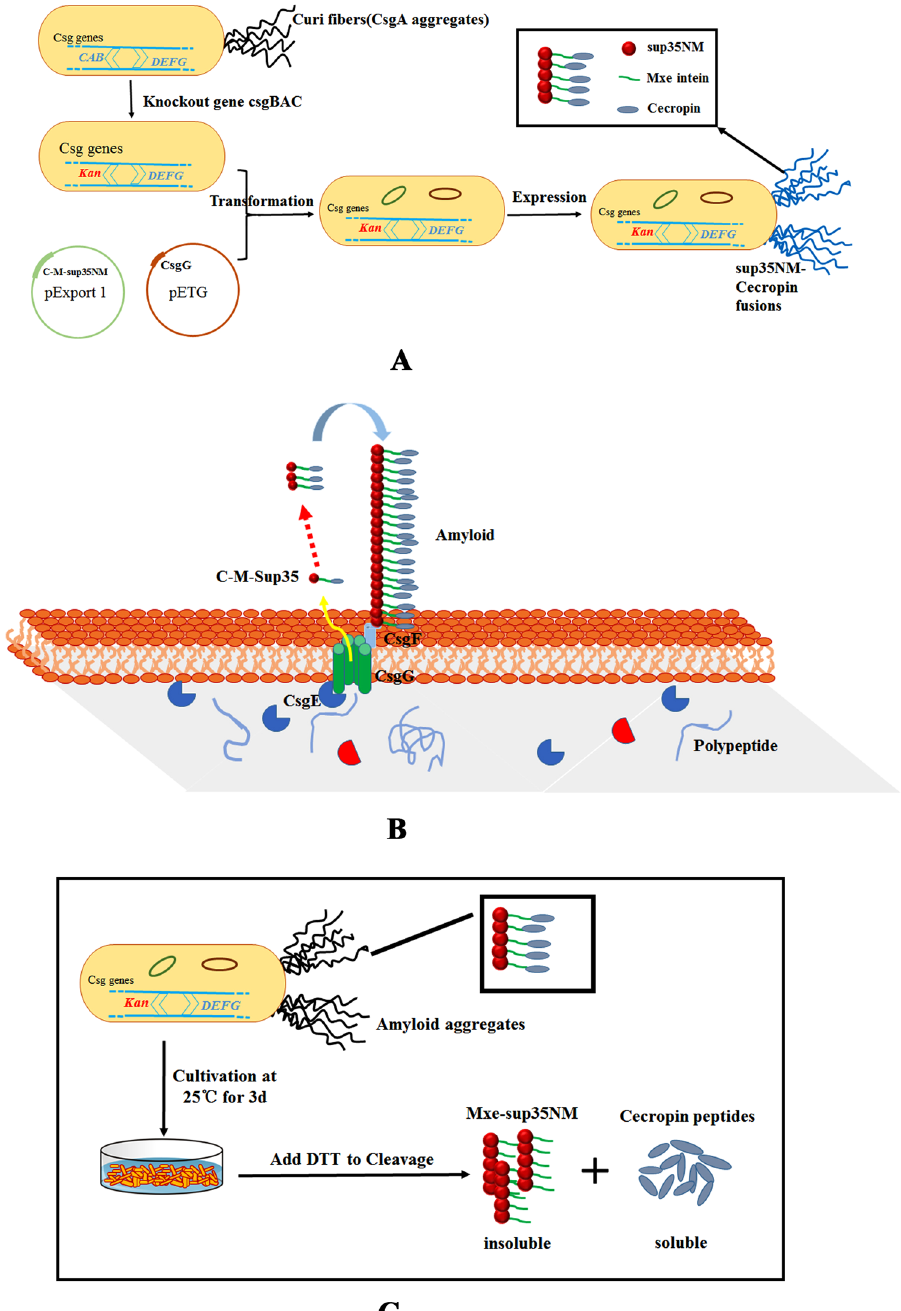
Figure 1. The technical roadmap for extracellular secretion and online-cleavage of antimicrobial peptides on the surface of Escherichia coli . ( A ) Strategy for generating extracellular fiber-like aggregates based on the E. coli curli system. A curli-deficient mutant of E. coli BL21 (DE3) was constructed by deleting csgBAC and replacing them with a kanamycin resistance gene. pExport 1, encoding a C-M-sup35NM fusion protein, and pETG, directing the overexpression of CsgG, were introduced into strain BL21 (DE3) ∆ csgBAC . The recombinant bacteria were then cultured on YESCA plates supplemented with appropriate antibiotics and inducers at 25 °C for 3 d to produce fiber-like aggregates (blue fibers). The black box shows the composition of the fiber-like aggregates. ( B ) Model of secretion and assembly principle CsgG forms an ungated peptide diffusion channel in the cell outer membrane (OM). C-M-sup35NM fusions firstly pass through the inner membrane (IM) into the periplasm via the Sec-pathway, and are then secreted to the cell surface of BL21 (DE3) ∆ csgBAC in a CsgG- and CsgE-dependent manner. The secreted C-M-sup35NM fusions tend to form fiber-like aggregates because of the amyloid of sup35NM. CsgF associates with the OM and is required for adhesion of the C-M-sup35NM aggregates. ( C ) Schematic diagram of cleavage experiment mediated by Mxe GyrA BL21 (DE3) ∆